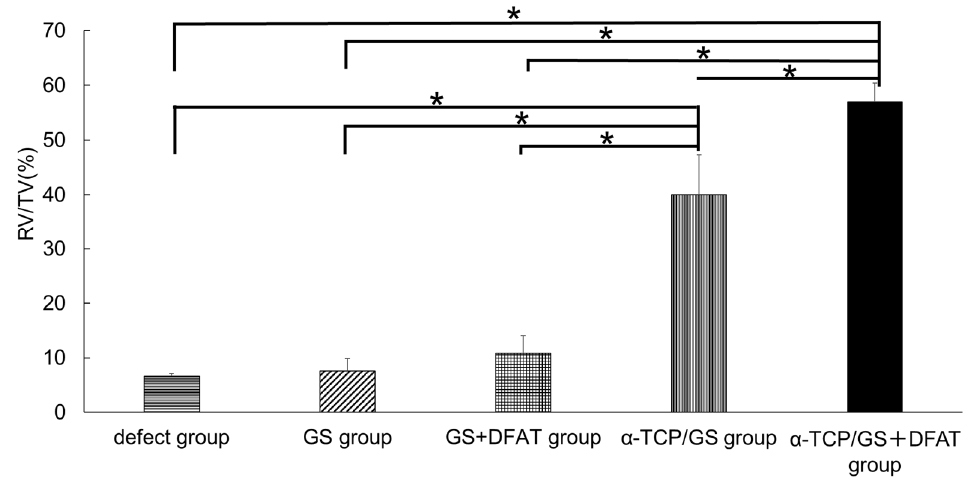
Figure 14. Results of µ -CT analysis of bone mass µ -CT, micro-computed tomography; RV, radiopacity volume; and TV, total volume. Bonferroni test; * p < 0.05; n = 4.